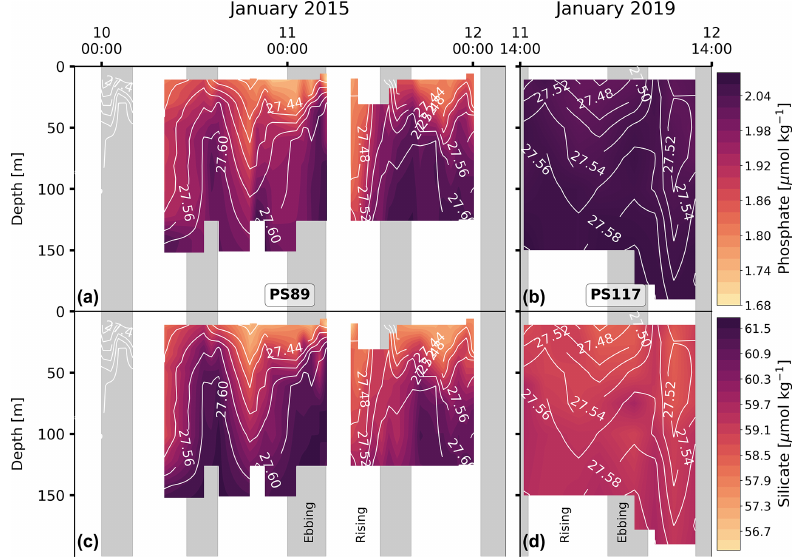
Figure G2. The same as for Fig. G1 but for phosphate and silicate content and not including the pH and calcite saturation contours that are shown in Fig. G1.